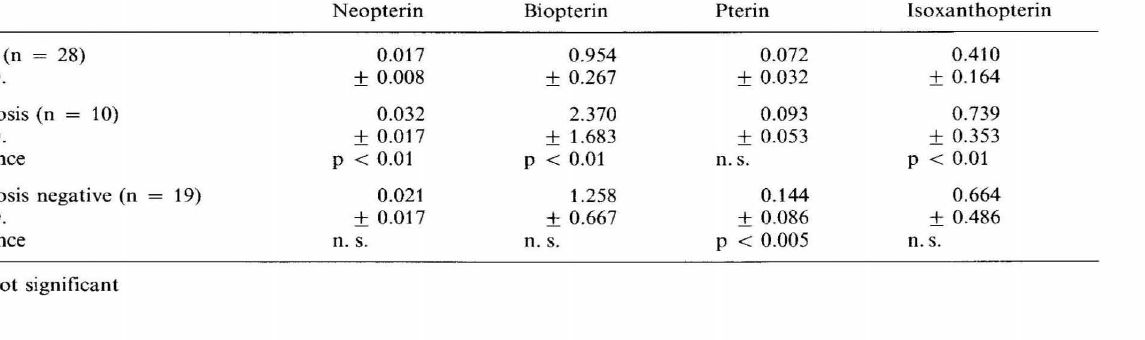
Table 2. Urinary pteridine levels of dogs with parvovirosis in comparison to healthy dogs (in Ilmol/mmol creatinine).